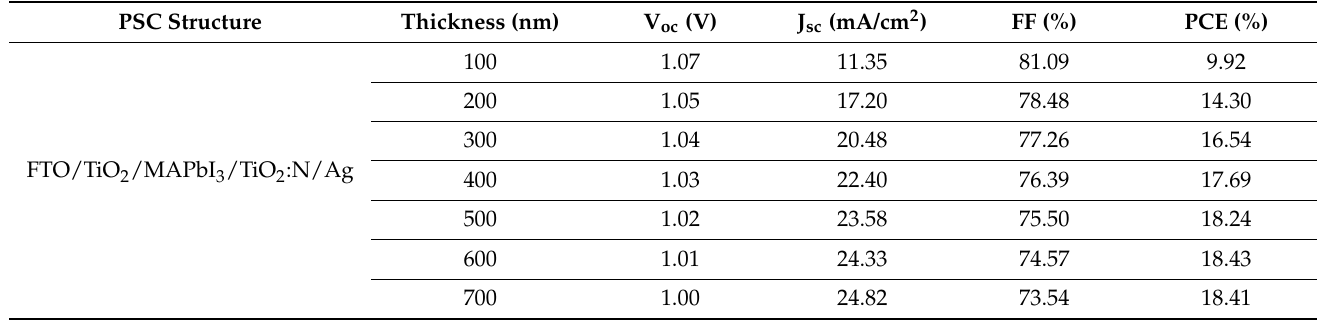
Table 3. Performance parameters for both recipes with varied absorber